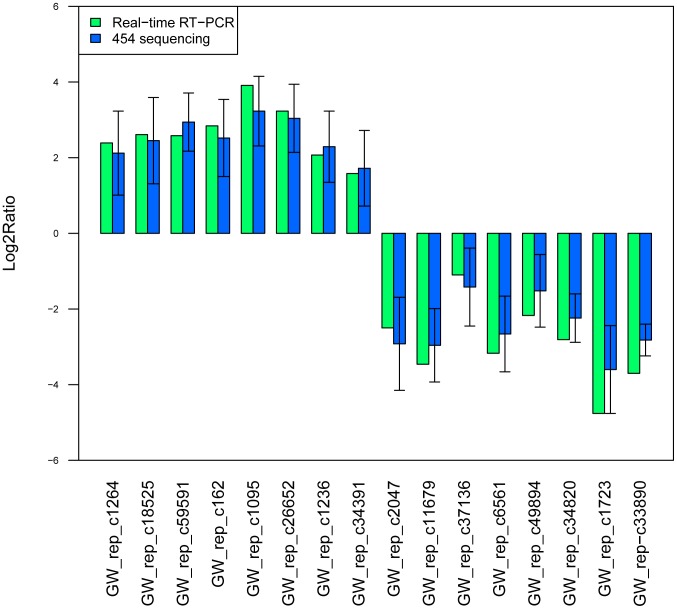
Histogram, Comparison of gene expression between qRT-PCR and 454 sequencing analysis.The qRT-PCR are presented as the mean values of three repeats.